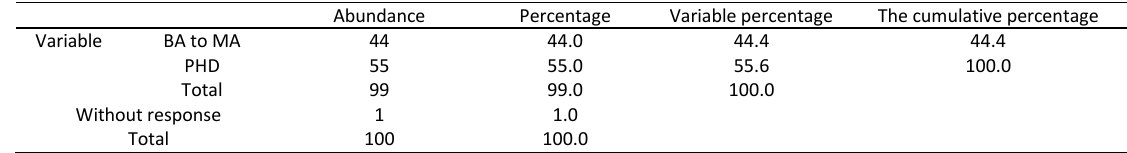
Table 6: Composition in terms of education